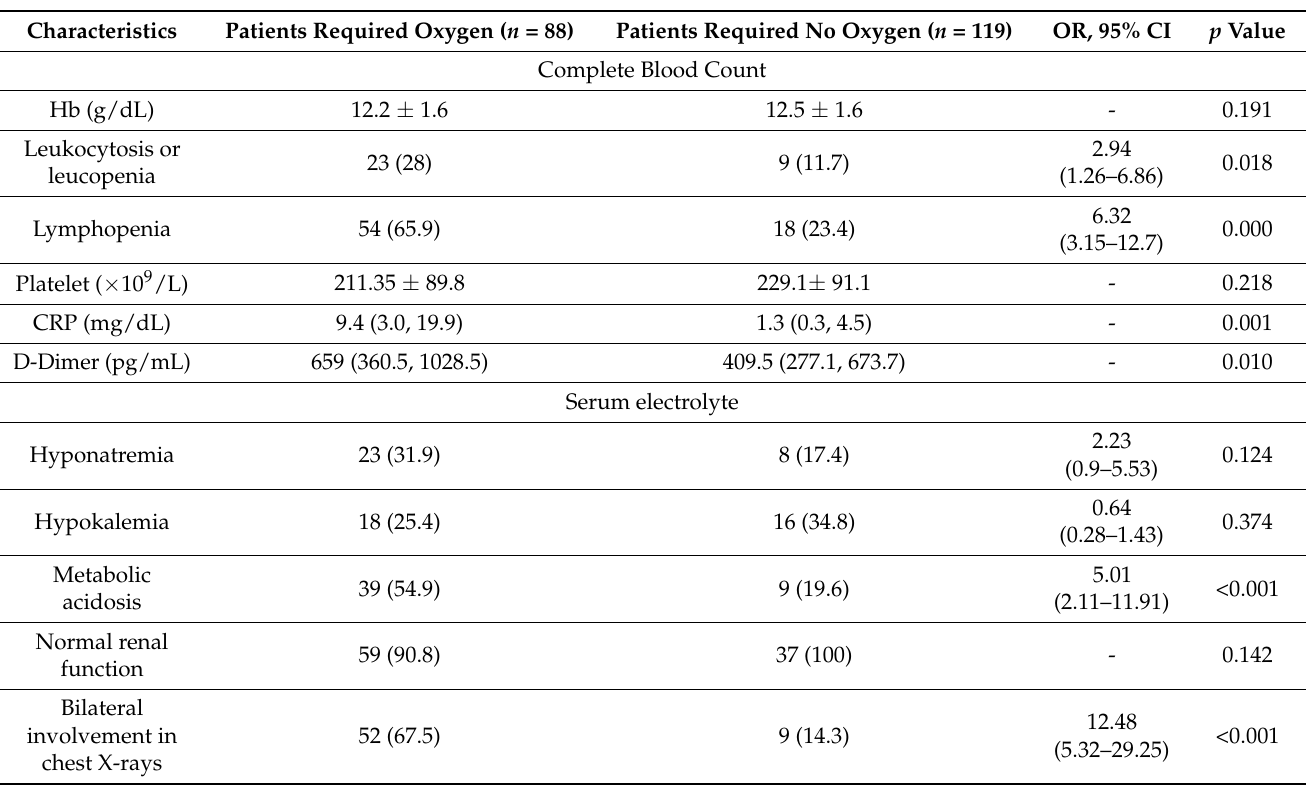
Table 2. Laboratory profiles of in-patient COVID-19 cases at admission.